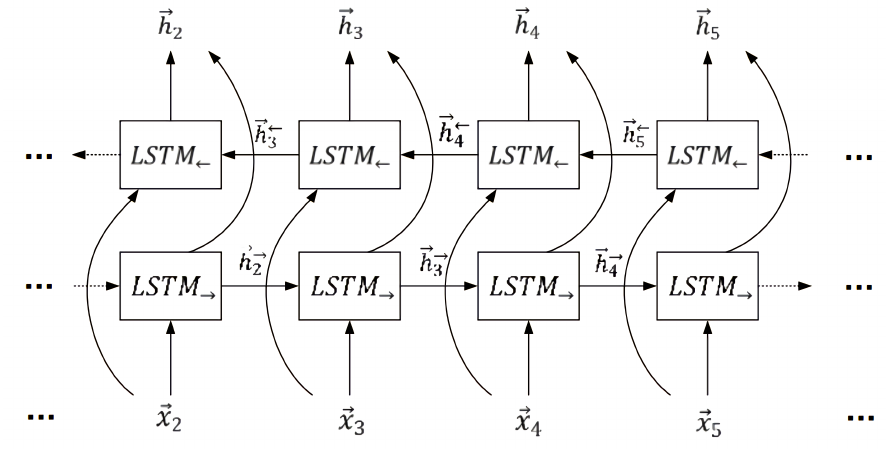
Figure 4. BILSTLM Network